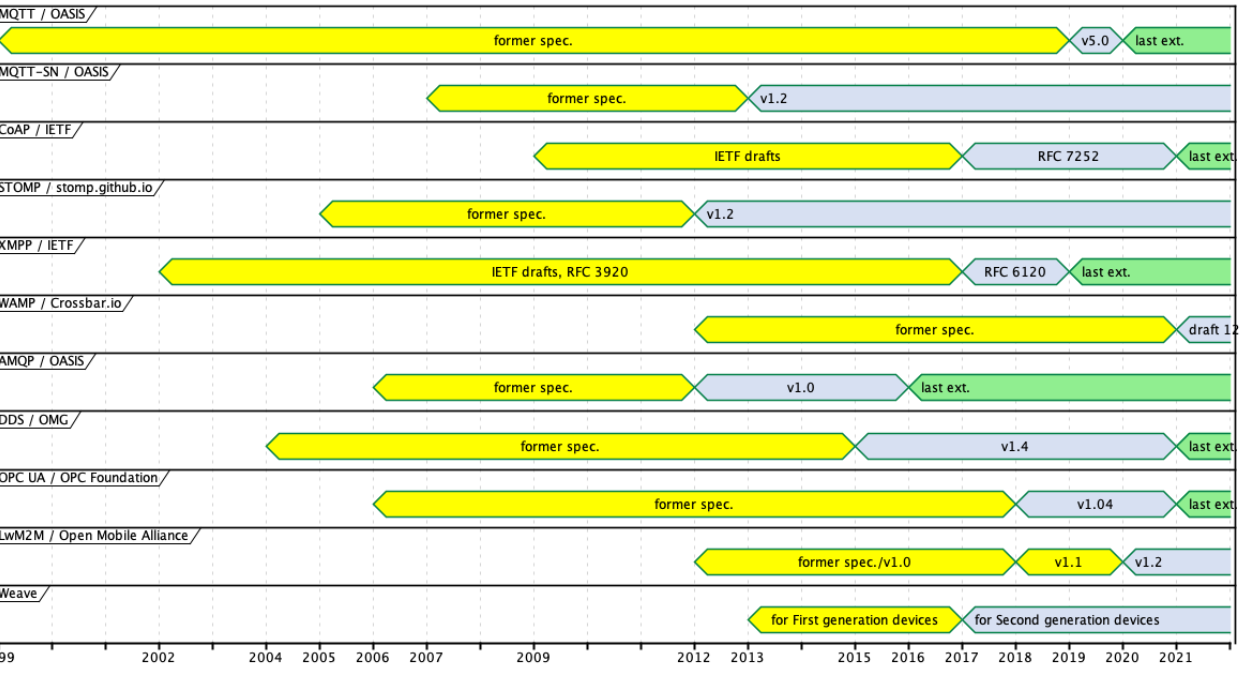
Figure 1. The years of the protocol specification appearance.